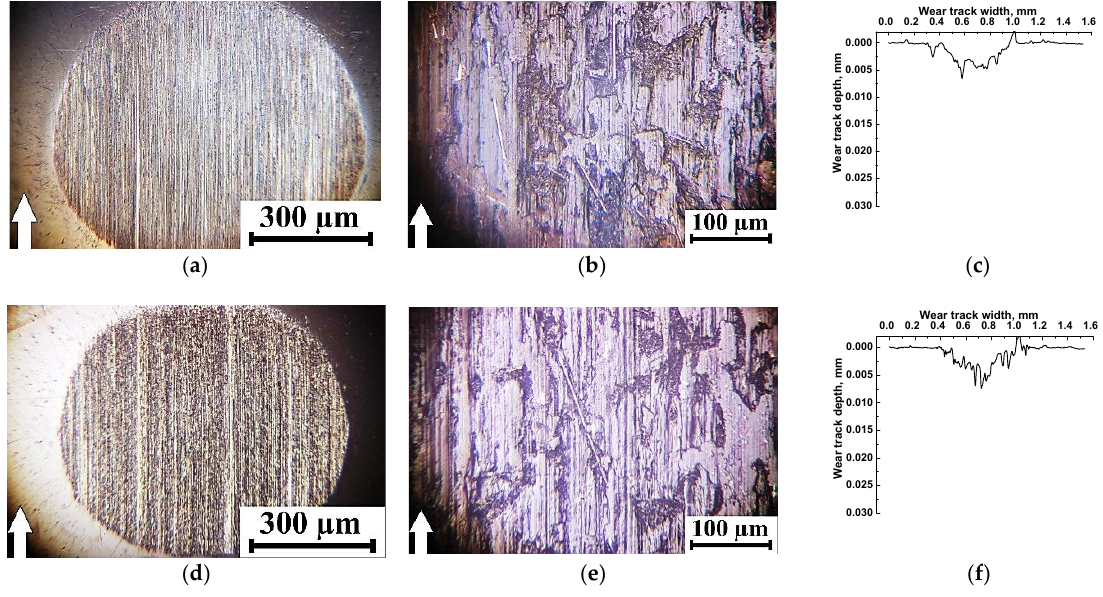
Figure 4. Optical photographs of the steel counterpart surfaces ( a , d ), wear tracks ( b , e ) and wear track profiles ( c , f ) after the tribological tests of the PI/10CCF/1CNT ( a – c ) and PI/10CCF/1HNT ( d – f ) nanocomposites. Point tribological contact. White arrows denote sliding direction.